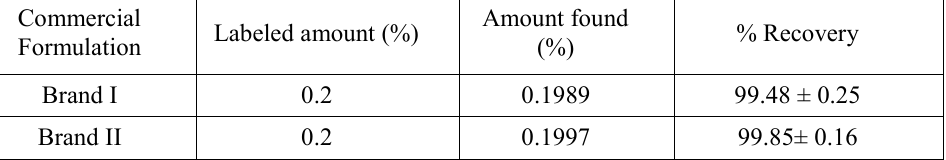
Table 1. Analysis of commercial formulations (Eye Drops).